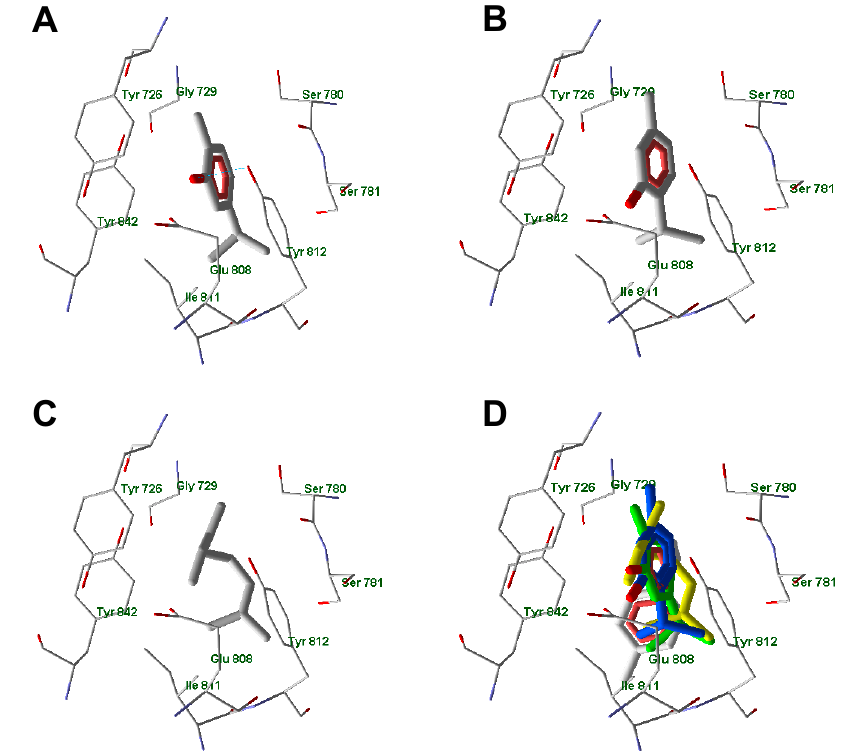
Figure 7. Docking poses of carvacrol ( A ), thymol ( B ), and β -myrcene ( C ). Superimposed docking poses of carvacrol (green skeleton), thymol (blue skeleton), β -myrcene (yellow), and inactive compound p -cymene (grey) ( D ). Residues within 6 Å of the center of the search space are shown.